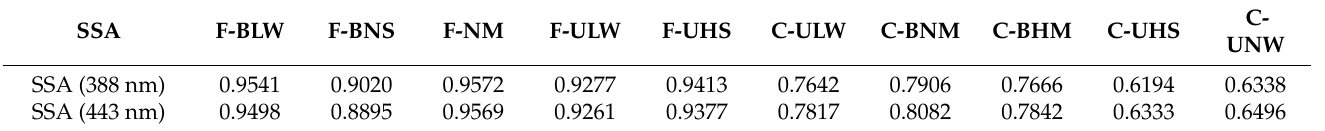
Table 5. SSA of ten aerosol models at 338 nm and 443 nm.